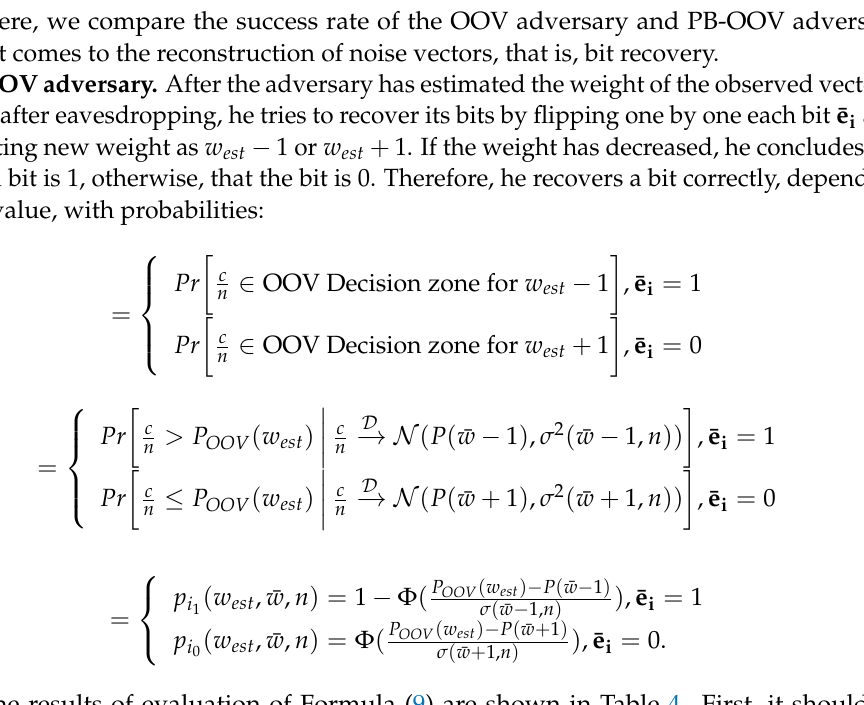
Table 3. Precision of the proposed PB-OOV algorithm meets the targeted precision for weight estimate. Parameter Set I Parameter Set II HB# Random-HB# HB# Random-HB# targeted precision 0.999315 0.999997 0.998641 0.999992 = 1 − erfc ( θ ) real precision